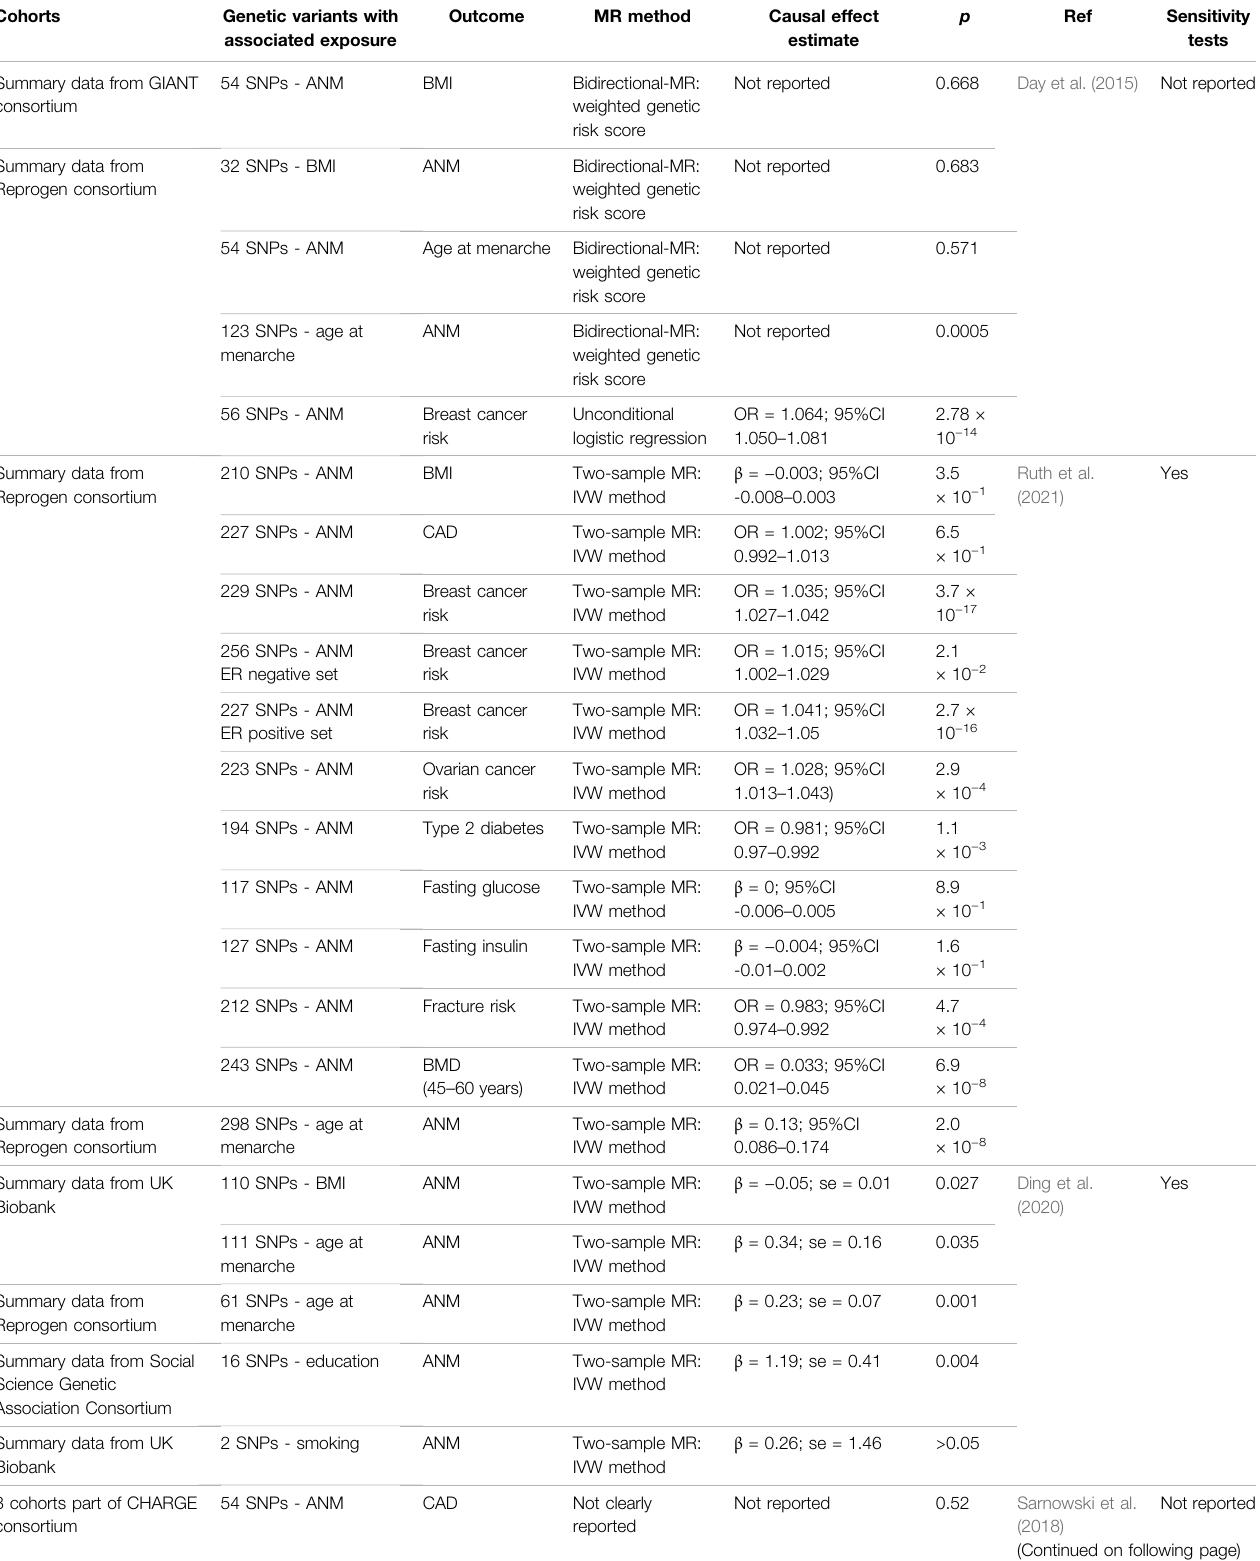
TABLE 1 | Overview of mendelian randomization studies for age at natural